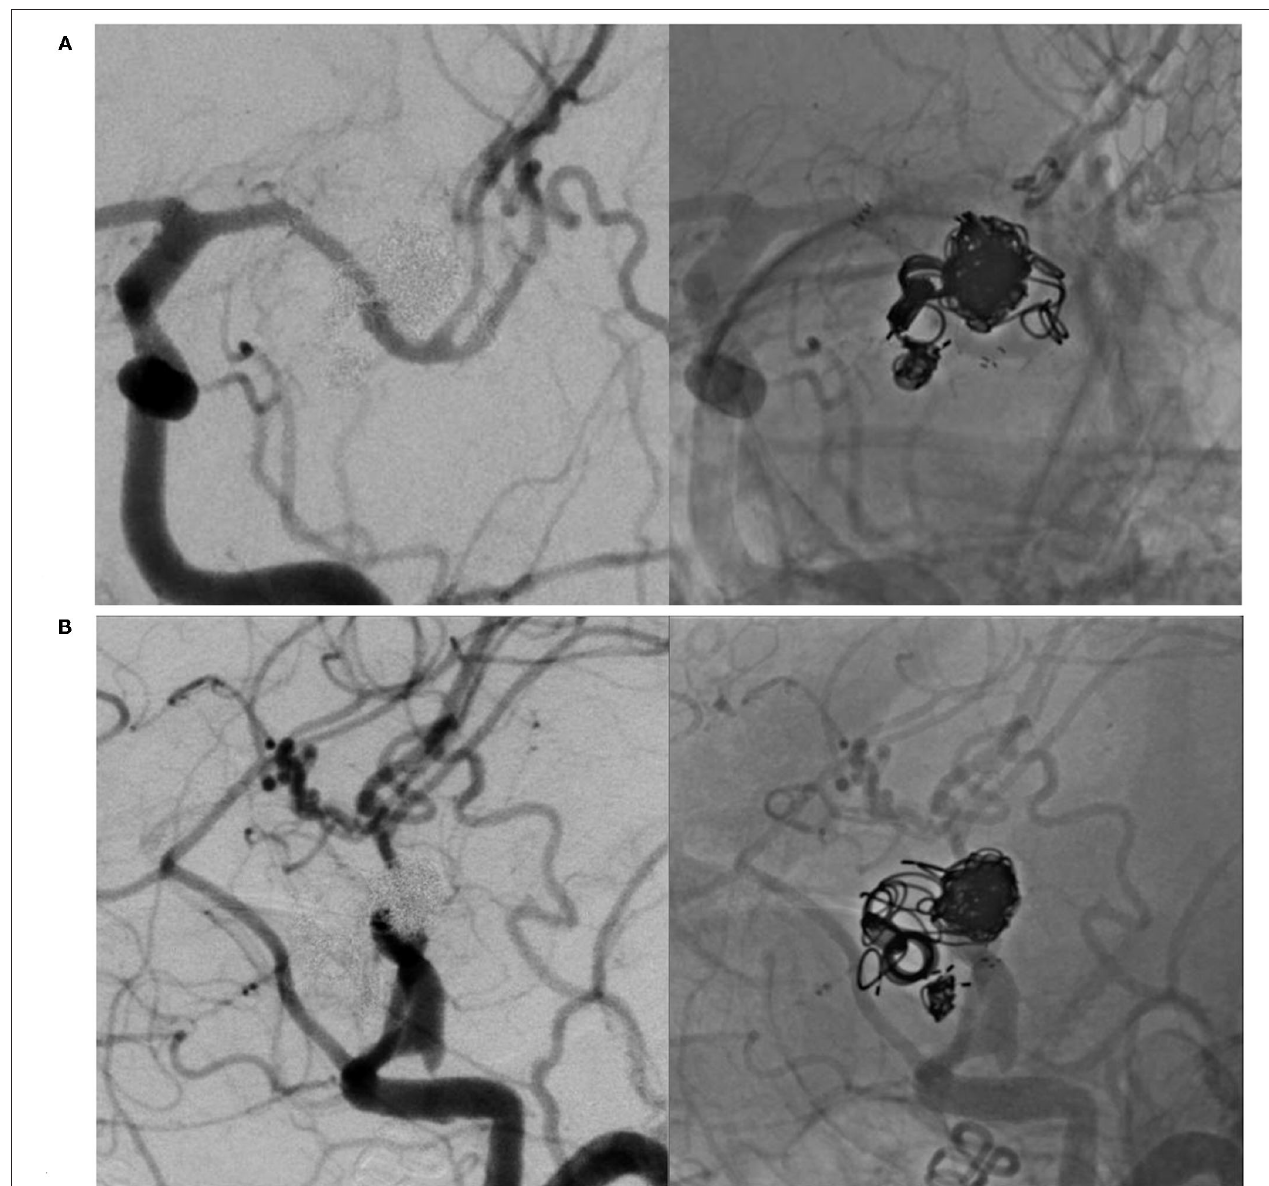
FIGURE 5 | Left internal carotid angiography 3 months after treatment reveals complete occlusion of the aneurysm with endothelialization of the neck. (A) In an antero-posterior view. (B) In a lateral